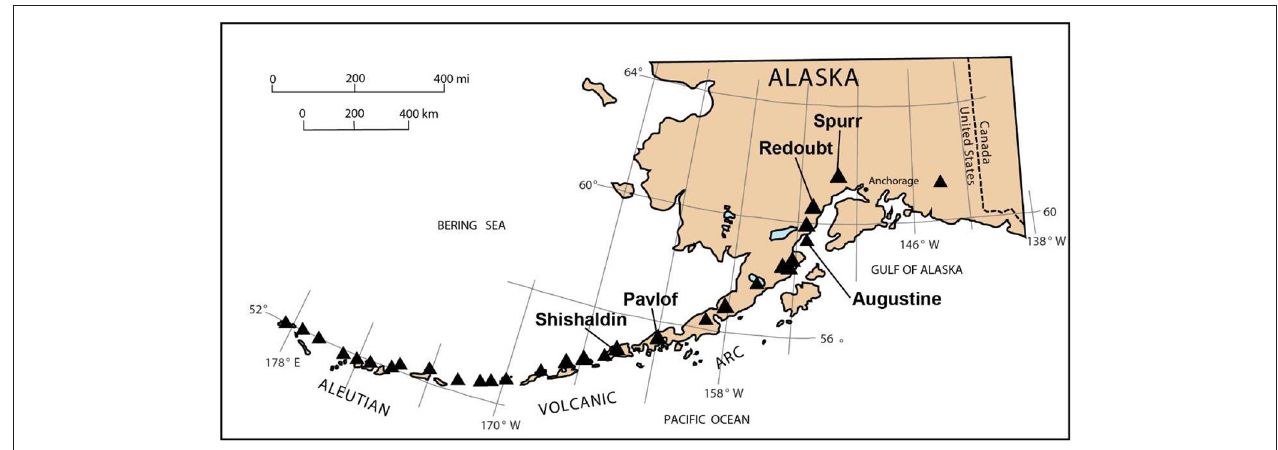
FIGURE 1 | Map showing locations of historically active volcanoes in Alaska as triangles. Labels indicate locations of volcanoes discussed in this report.